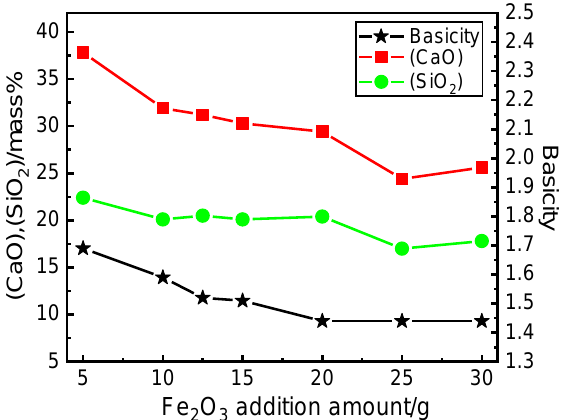
Figure 5. Effect of the Fe 2 O 3 addition amount on the contents of CaO and SiO 2 in the slag and the basicity after dephosphorization.